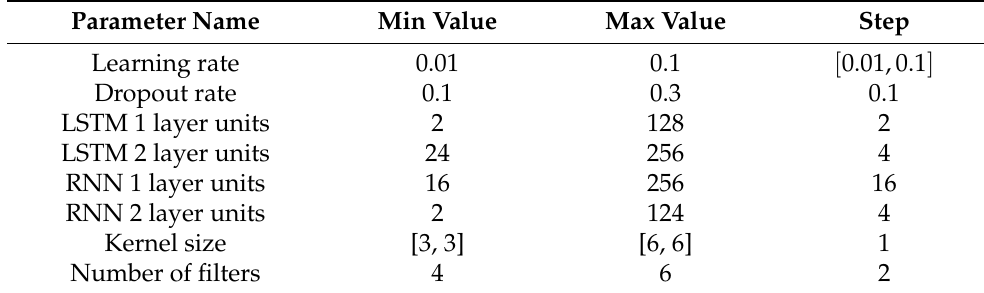
Table 1. Parameters used for tuning the neural